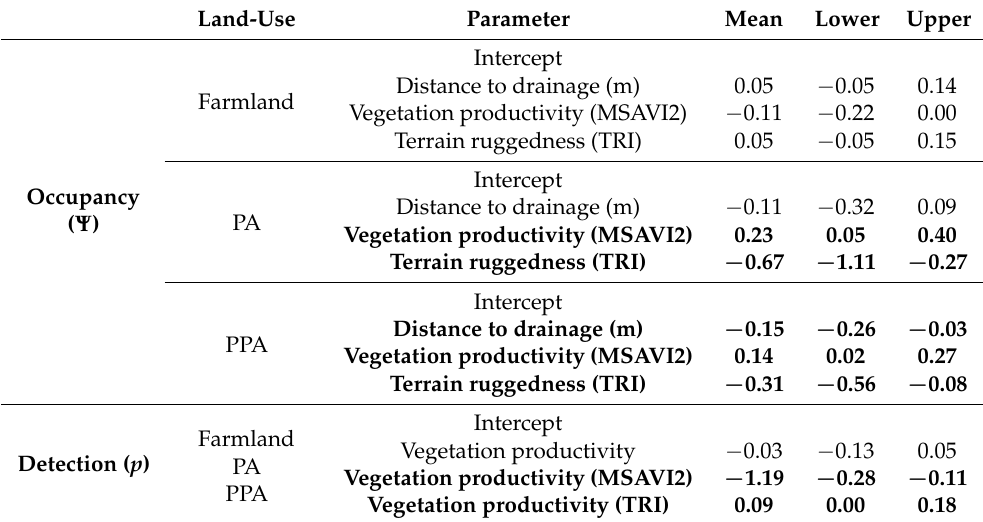
Table 1. Mean and associated 95% Bayesian credible intervals (BCIs) of community-level hyper- parameters hypothesised to influence the probability of use and detection of mammal species (>0.5 kg) across three land-uses (farmland, PA and PPA). Bold denotes covariates with significant effects. Parameters include distance to drainage line (m), vegetation productivity (MSAVI2) and terrain ruggedness (TRI) on the occurrence probability, and MSAVI2 on the detection probability. Land-Use Parameter Mean Lower Upper Intercept Distance to drainage (m) 0.05 − 0.05 0.14 Farmland Vegetation productivity (MSAVI2) − 0.11 −